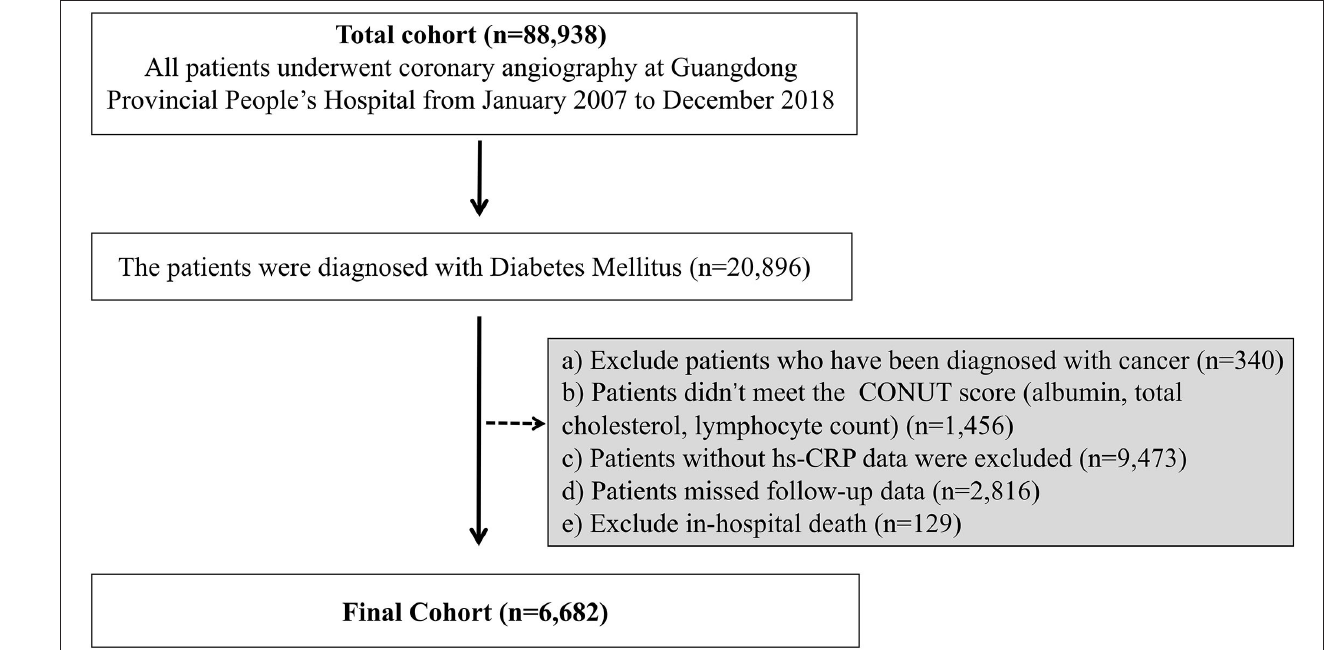
FIGURE 1 | Patient flow